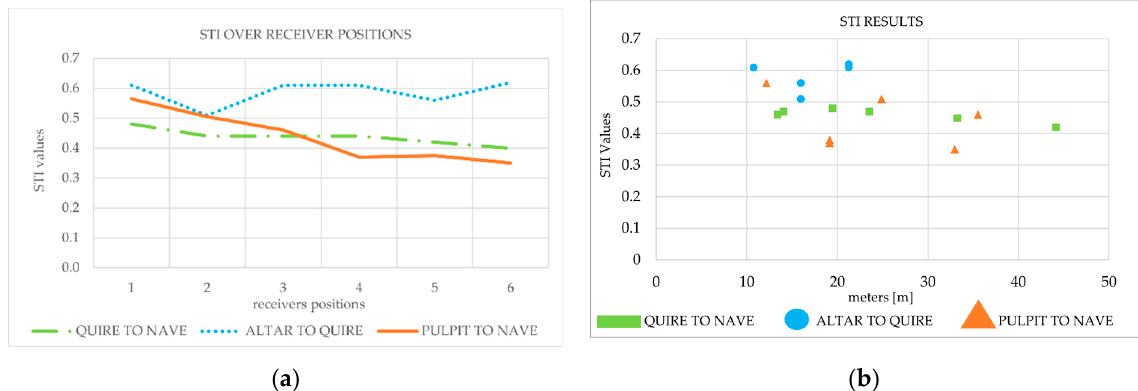
Figure 13. STI results: ( a ) STI results over receiver positions; ( b ) STI results over distance.